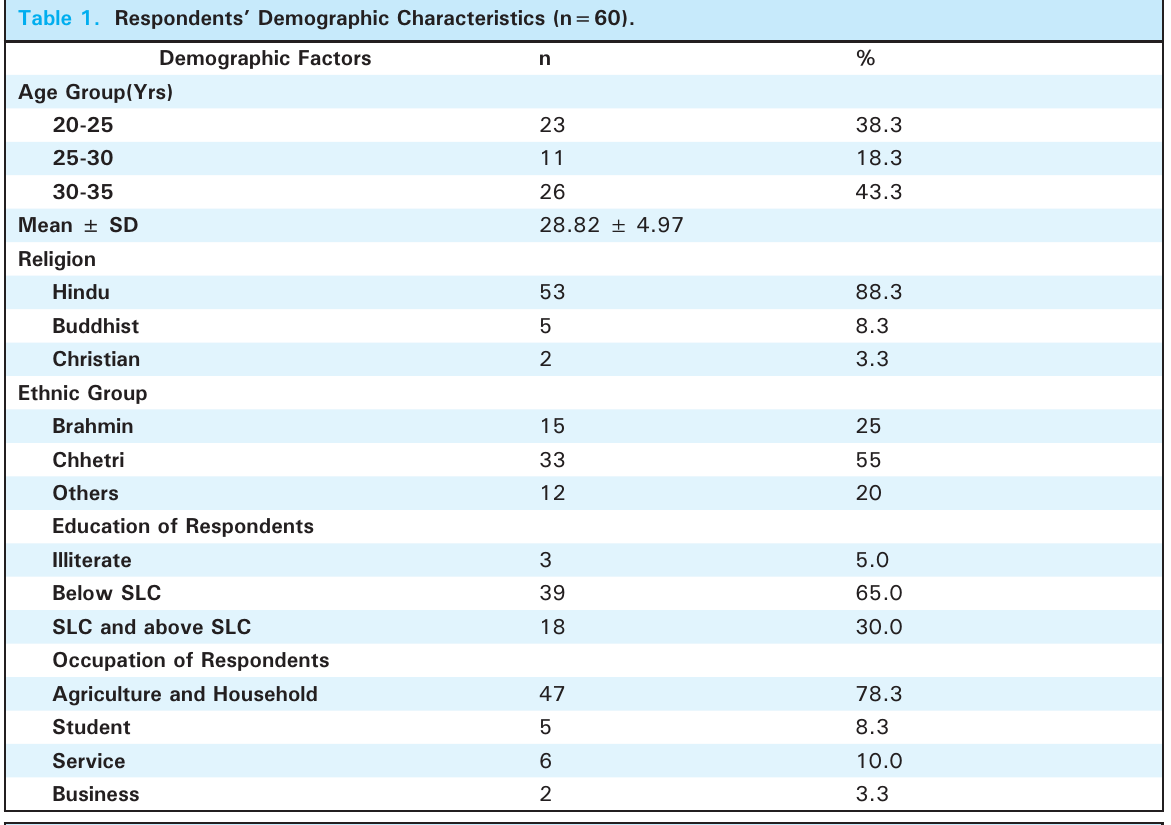
Table 1. Respondents’ Demographic Characteristics (n=60).